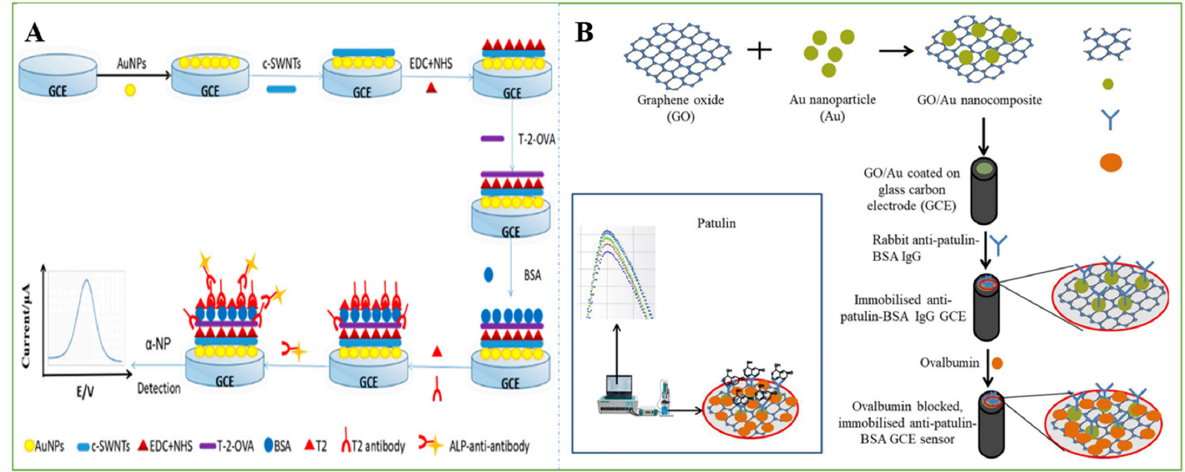
Figure 4. ( A ) The fabrication process of this electrochemical biosensor [62]. Reprinted from MDPI, 2018. ( B ) Schematic illustration on the preparation of immobilized GCE sensor for the detection of patulin. Reprinted with permission from [69]. Copyright 2021 Elsevier.